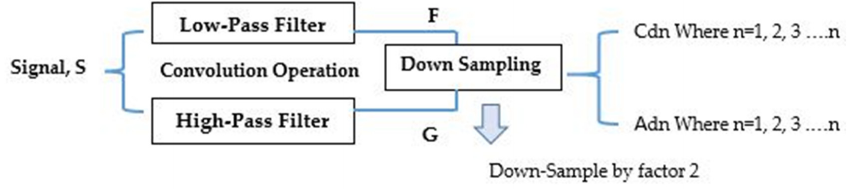
Figure 5. Decomposition procedure for the DWT: representation of the low-pass and high-pass filters, convolving with signal ‘S’. (Figure Reduced in size-300 dpi). Recalling the wavelet coefficient γ of a signal 𝑥(𝑡) is a projection of 𝑥(𝑡) onto a wavelet, and let 𝑥(𝑡) be a signal of length 2 (cid:3015) , in the case of child wavelet in the discrete family above.